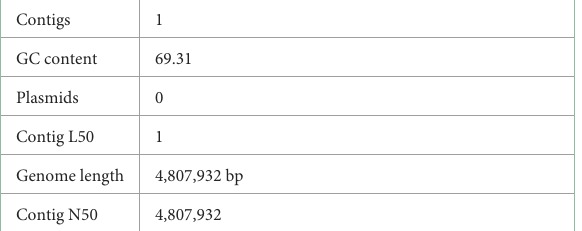
TABLE 1 Assembly details for M.ap 1 LipN